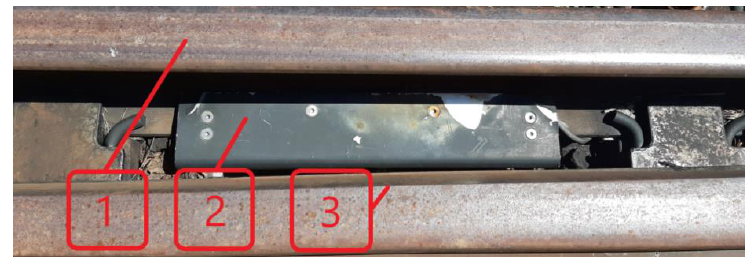
Figure 4. IH device heating part (2) mounted between the stock rail (1) and the switch rail (3).